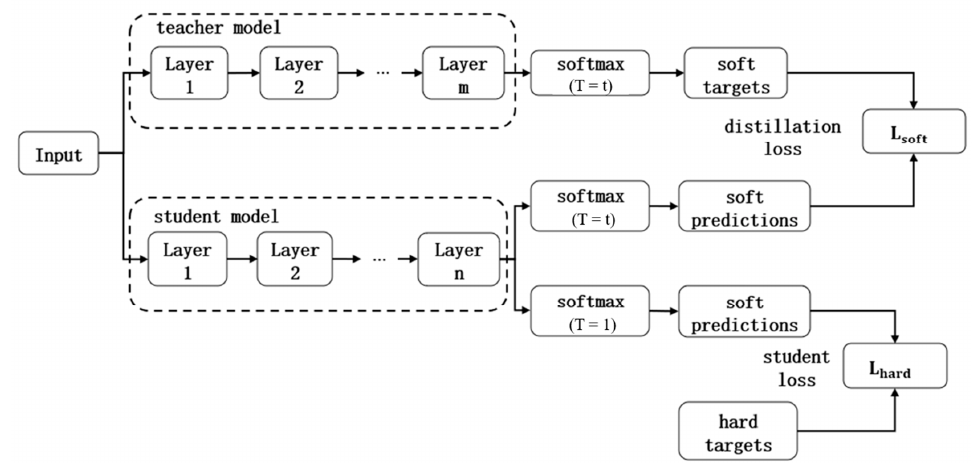
Figure 3. The KD structure. Firstly, a “teacher” network whose network depth and width were